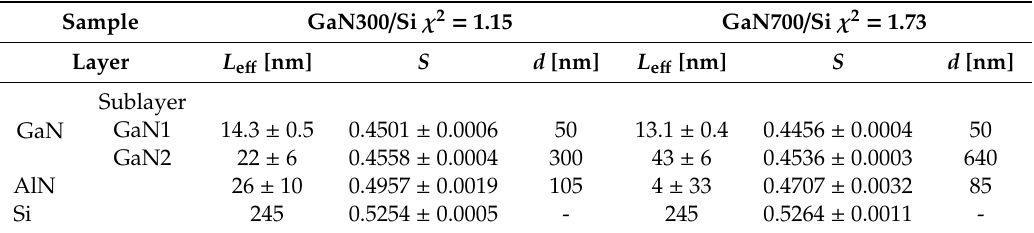
Table 2. Best fit parameters obtained by VEPFIT from the S ( E + ) and F Ps ( E + ) depth profiles. The values without error margins are fixed